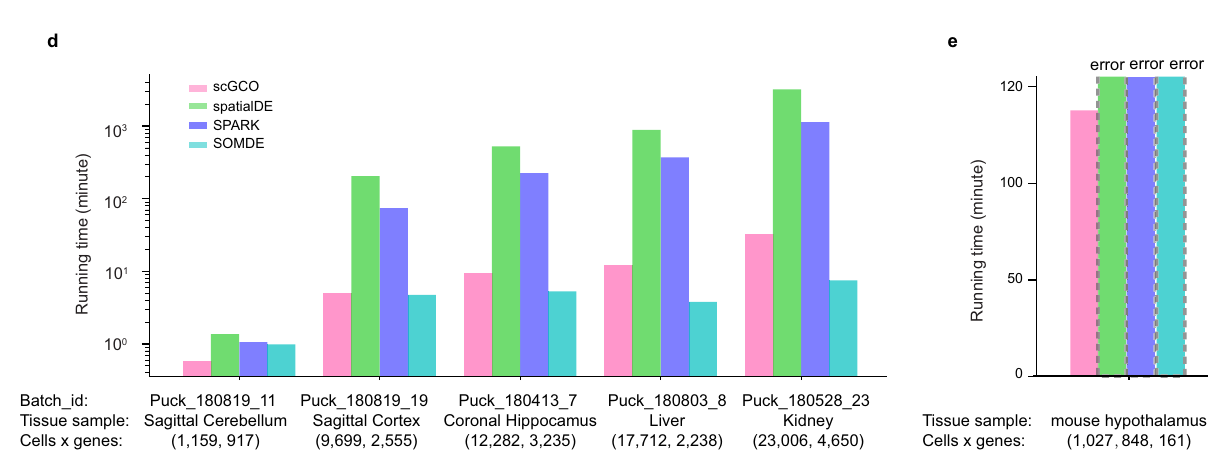
Fig. 7 | ScalabilityofSVgene identi fi cationalgorithms.a Memoryrequirements of scGCO,SPARK,spatialDE,trendSceek,and SOMDE in the number of cells(using 100 genes) on simulated data. b Running time of scGCO, SPARK, spatialDE, tren- dSceek, and SOMDE in the number of cells (using 100 genes) on simulated data. Dotted line indicates memory or running time extrapolated from measured data. c Running time on adult human heart tissue data with Spatial Transcriptomic